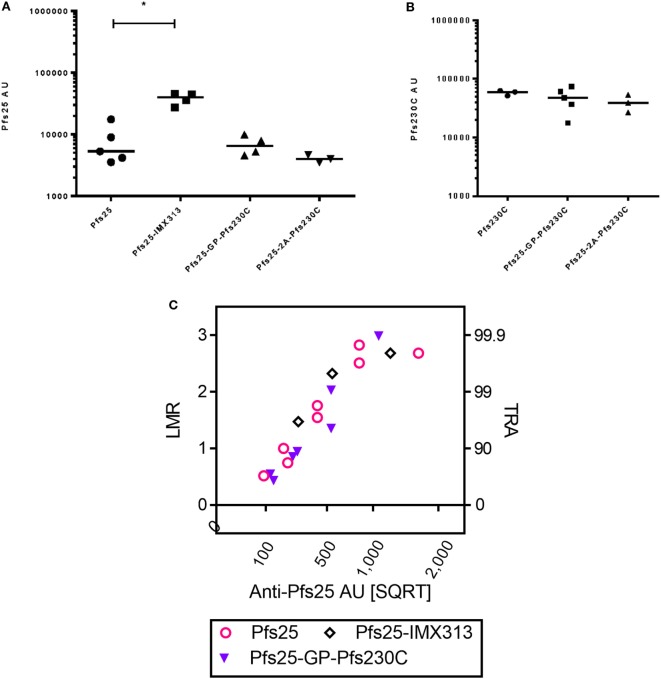
Immunogenicity and transmission reducing ability in standard membrane-feeding assay (SMFA) induced by vaccination with chimpanzee adenovirus 63 (ChAd63)–modified Vaccinia Ankara (MVA) expressing single antigen, dual-antigen, or IMX313 vectors in mice. Day 70 antigen-specific IgG responses in mice after immunization with ChAd63–MVA expressing single antigens Pfs25 or Pfs230C and dual-antigen antigens linked with glycine–proline or 2A (experiment 6, n = 5/group). Another group of mice were immunized with Pfs25-IMX313. The figure shows the total IgG response against Pfs25 (A) and Pfs230C (B). Response was measured by standardized ELISA and is expressed in antibody units. Kruskal–Wallis tests [p = 0.0107 (A) and p = 0.4249 (B)] followed by Dunn’s tests were performed; p value by Dunn’s test is shown. Pfs25-2A-Pfs230C was eliminated from these statistical tests as only three mice remained at the end of the study. Total IgG was purified from the pooled day 70 serum, and each IgG was tested at two to five different total IgG concentrations each in two to three independent SMFA assays (Table S4 in Supplementary Material). The square root of anti-Pfs25 AU (C) in the feeder is shown on the x-axis. The log-transformed mean oocyst ratio between test and control (LMR) are plotted on left side of y-axis, and the associated % inhibition in oocyst density (TRA) is shown on the right side of the y-axis.